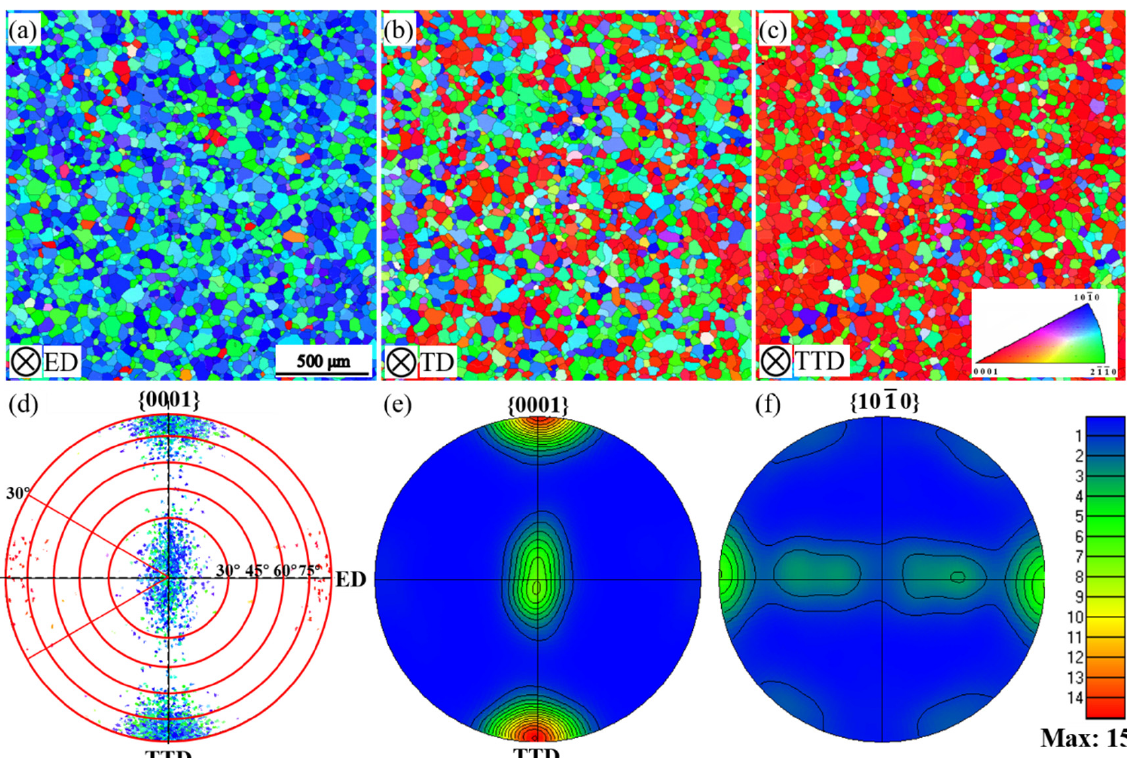
Figure 2. Microstructure and texture of the extruded Mg-9Al plate after solution treatment: ( a – c ) inverse pole figure maps viewed from ED, TD, and TTD, respectively; ( d , e ) {0001} pole figure in the scattered point and calculated contour line form; ( f ) {10 10} pole figure in the scattered point and calculated contour line form respectively.